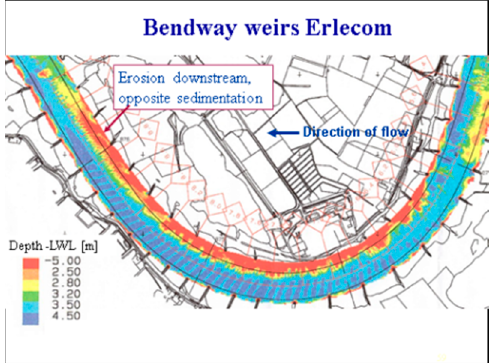
Figure 18. Location of bendway weirs at Erlecom (copyright RWS).